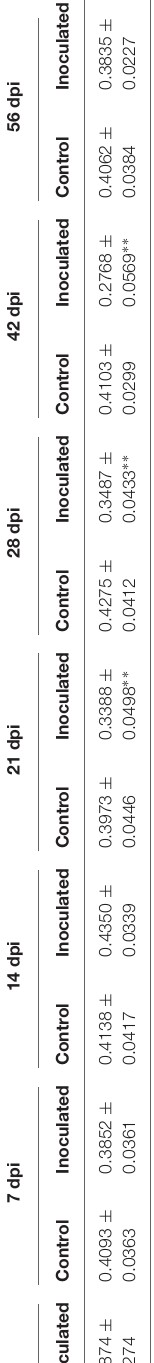
The obtained ATPase activity levels are presented in Table 2 . At 0, 7, and 14 dpi, no differences in the ATPase activity between the control and inoculated groups were observed. However, ATPase activity in hepatocytes significantly decreased in the inoculated group at 21, 28, and 42 dpi, compared with that in the control group ( ∗ p < 0.05 and ∗∗ p < 0.01, respectively; Figure 3A ). Western-blot analyses demonstrated that the expression level of ATP5A1 decreased at 7, 14, 21, and 42 dpi, compared with those in the control group ( ∗ p < 0.05 and ∗∗ p < 0.01, respectively; Figures 3B,C ).